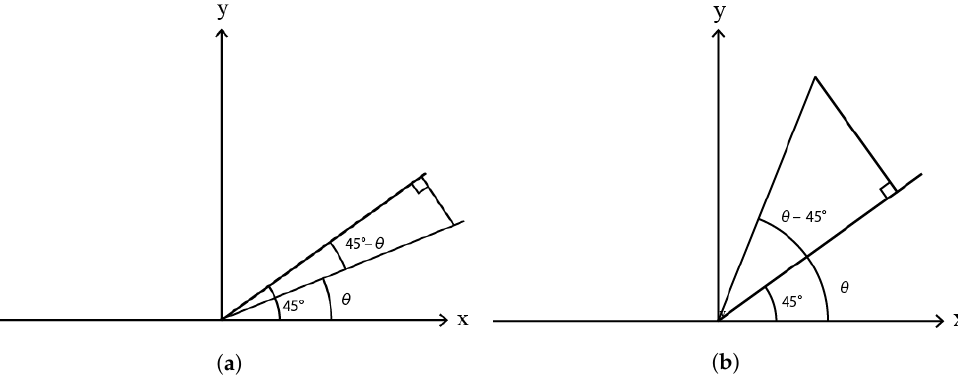
Figure 3. Projected gradient of 45 ◦ . ( a ) Projected gradient when θ is less than 45 ◦ ; ( b ) Projected gradient when θ is bigger than 45 ◦